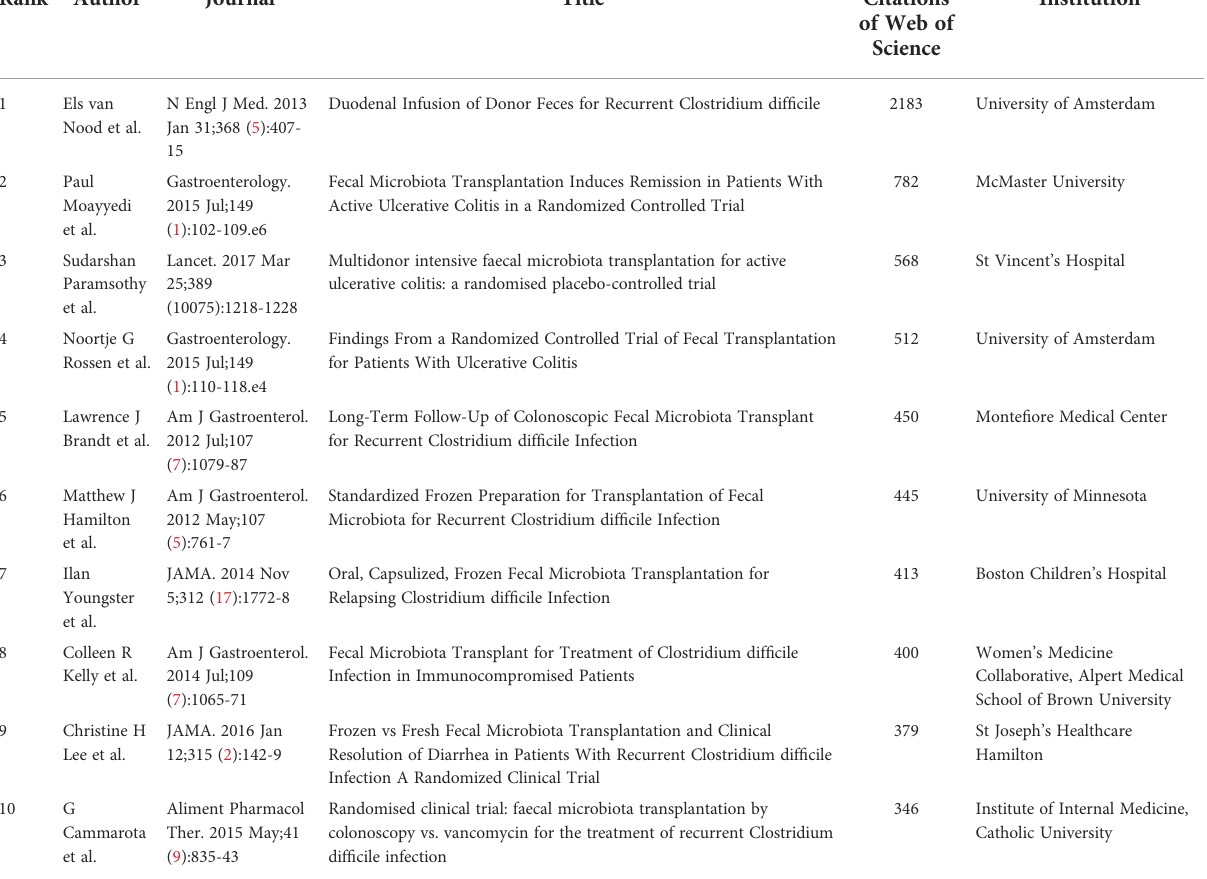
TABLE 1 The top 10 most cited articles in the fi eld of clinical fecal microbiota transplantation from 2001 to 2021.